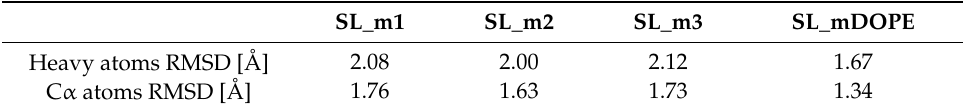
Figure 3. Normal modes analysis results of the ( A ) static loop (SL) and ( B ) flexible loop (FL) simulations using particular SL and FL models as starting points. The points representing SL_m1 and FL_m1 are blue, SL_m2 and FL_m2 are red, SL_m3 and FL_m3 are green, SL_mDOPE and FL_mDOPE are orange, and the wild-type of SL is black. Please note the spread of points on both graphs and that on the SL graph points representing simulations of three SL models are found on the same space (SL_m2, SL_mDOPE, and WT), while on the FL graph the points of three FL models overlap (FL_m1, FL_m2, and FL_m3) and one model is separated and less spread out (FL_mDOPE). Table 1. The RMSD (Root Mean Square Deviation) values of the averaged static loop (SL) structures compared with the averaged wild-type structure. For the RMSD calculations the mentioned atoms from the whole structure were used.